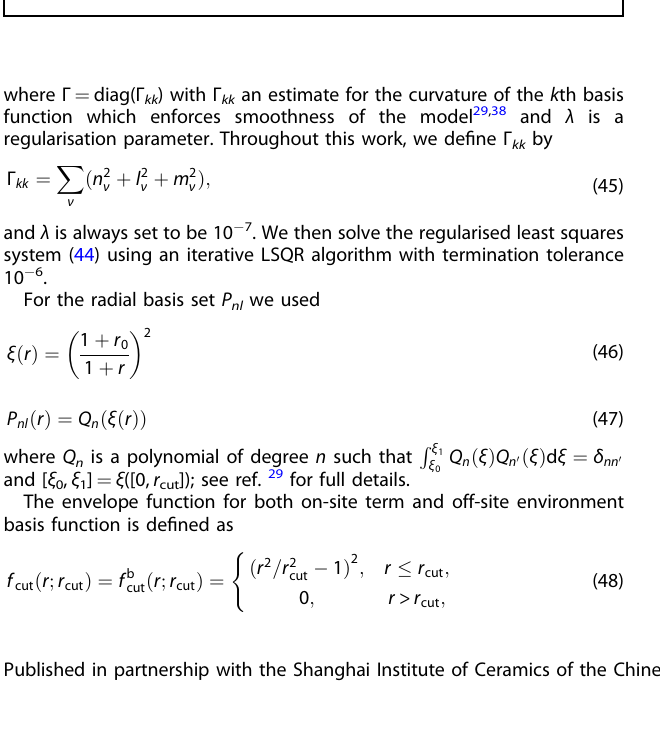
The error in the full DoS and in the occupied states below the Fermi level are reported.